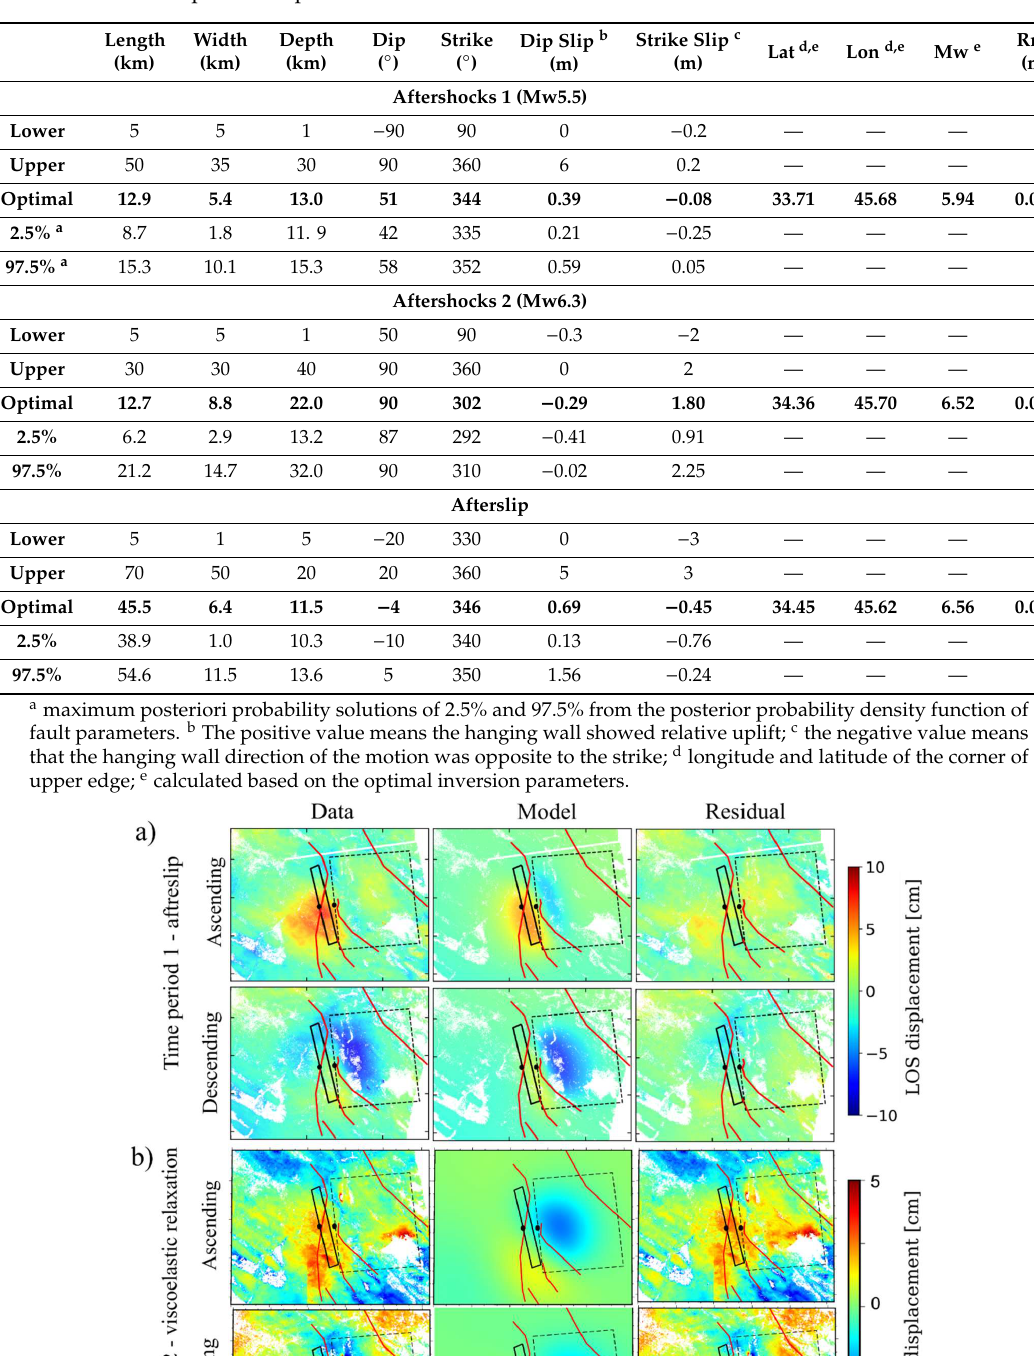
Figure 4. Best-fitting modelling results for ( a ) afterslip period (until June 2018) and ( b ) viscoelastic relaxation period (from June 2018 to February 2020). Black thin dashed rectangle: coseismic fault. Black solid rectangle: best-fitting afterslip dislocation. Black dot: upper edges of fault. Red lines: nearby faults. The reference point is shown in Figure 2.